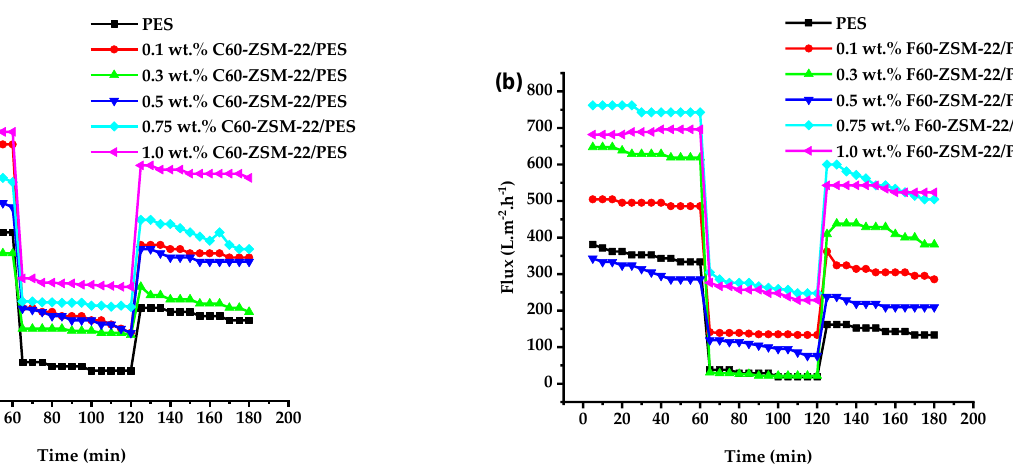
Figure 10. Antifouling analysis of nanofiltration membranes prepared via phase inversion to nominal wt.% loadings of 0, 0.1, 0.3, 0.5, 0.75, and 1.0 using ZSM-22 zeolite as nanoadditives: ( a ) C60-ZSM-22/PES and ( b ) F60-ZSM-22/PES.